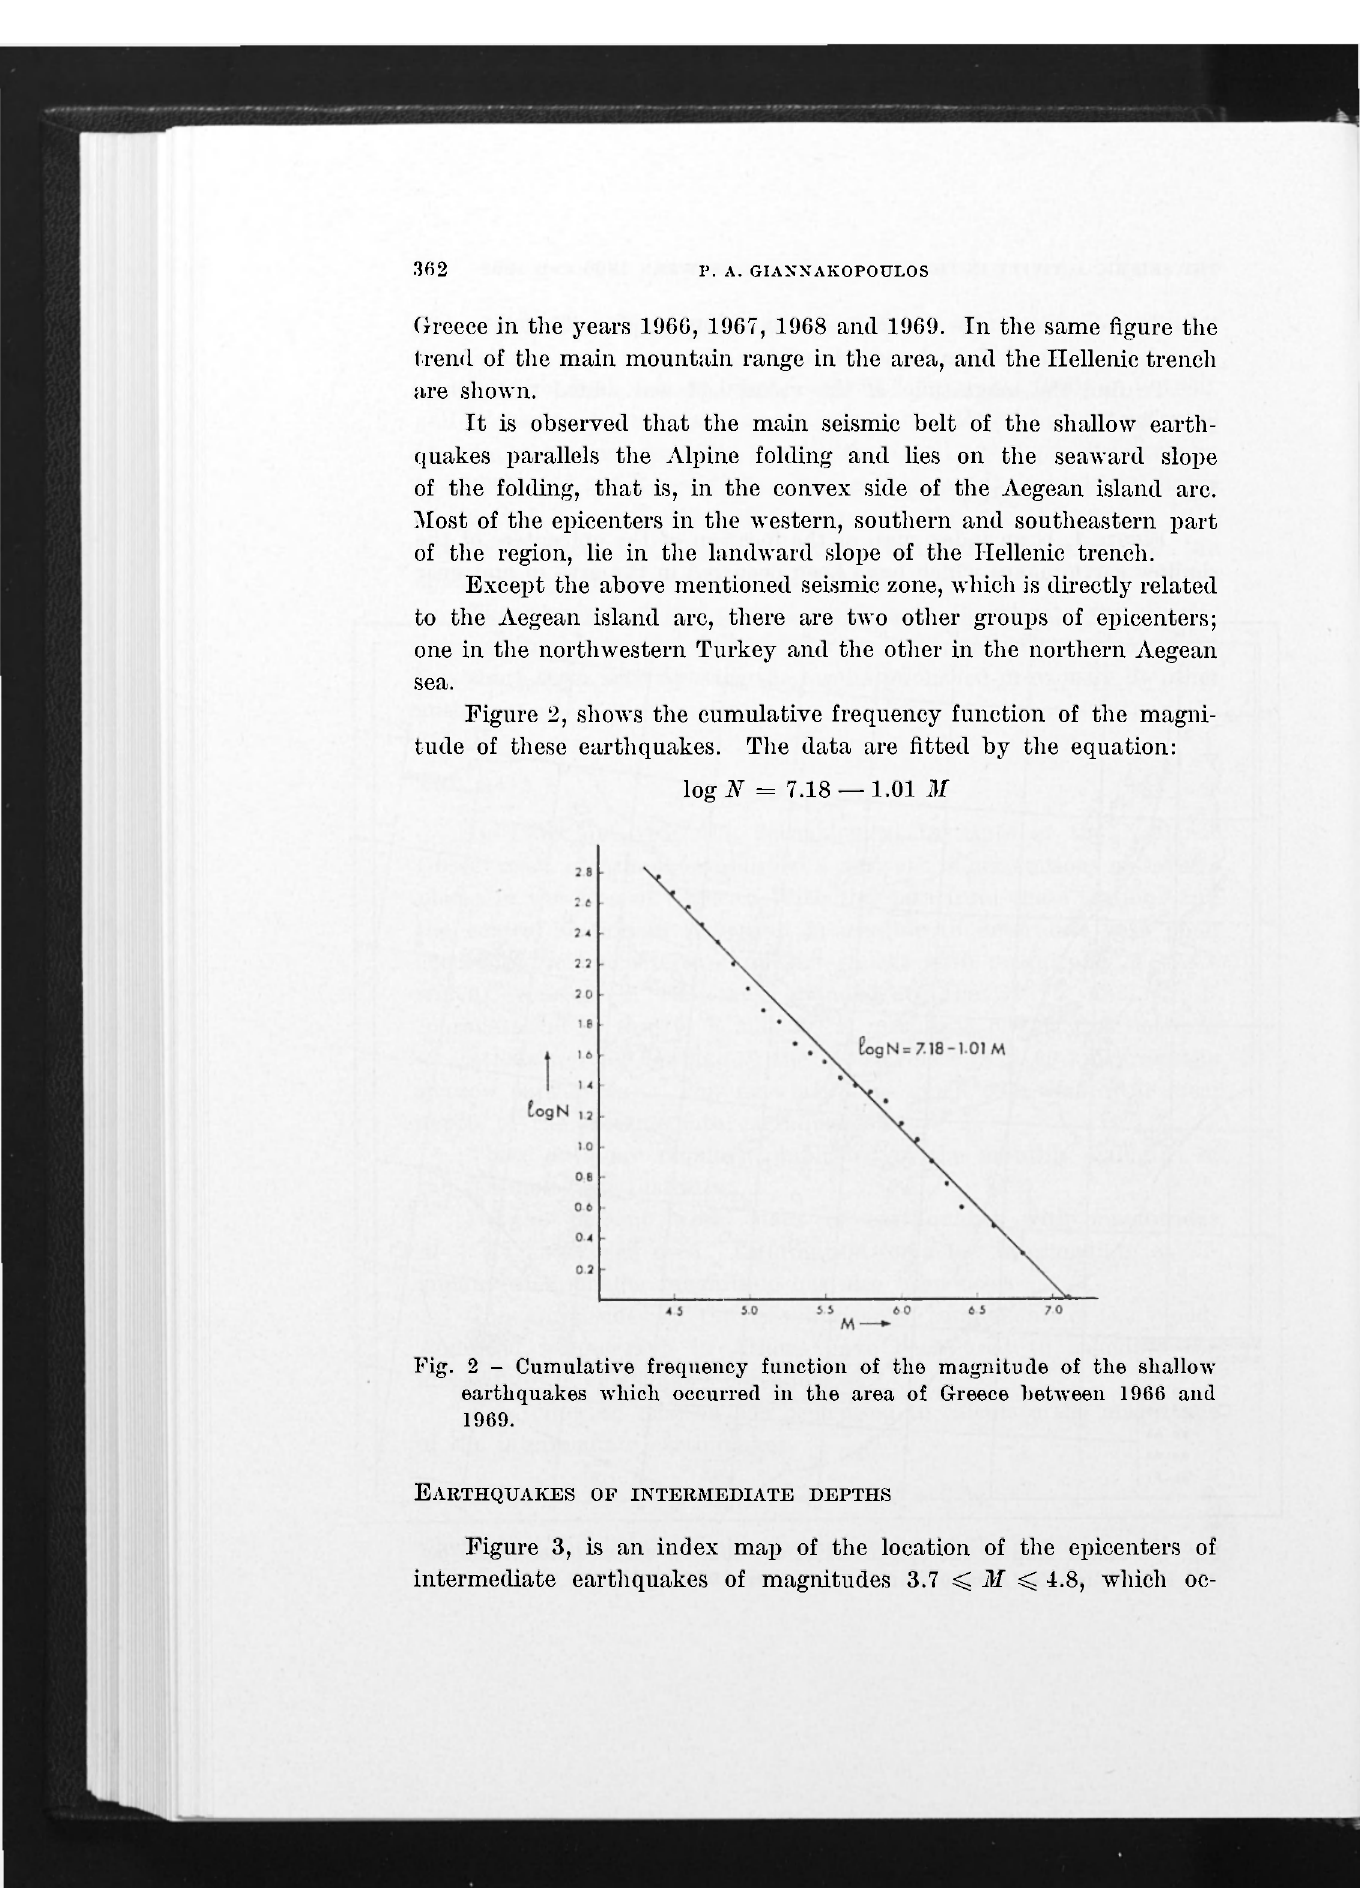
Figure 3, is an index map of the location of the epicenters of intermediate earthquakes of magnitudes 3.7 < M < 4.8, which